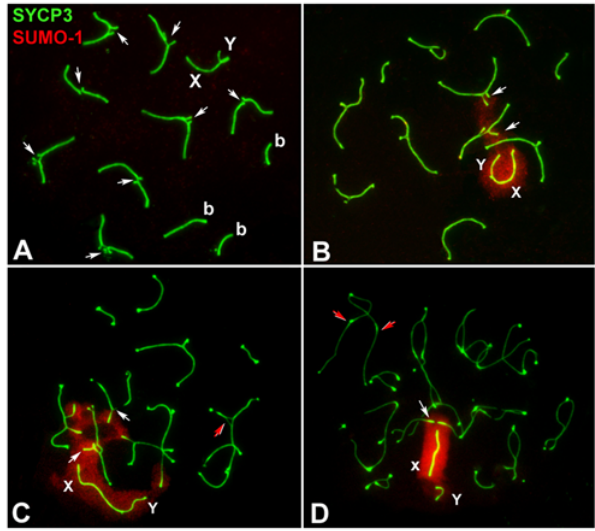
Figure 6. Localization of SUMO-1 (red) and SYCP3 (green) during prophase-I. (A) Early pachytene. SUMO-1 is not detected in both the chromatin of unsynapsed trivalents (arrows) and the XY body. (b) Bivalents. (B) Mid pachytene. SUMO-1 is only present in the chromatin of unsynapsed trivalents (white arrows) and the sex chromosomes (X, Y). (C) Early and (D) late diplotene. SUMO-1 persists in the unsynapsed chromatin (white arrows) and it is not present in the separated segments of homologous chromosomes (red arrows).